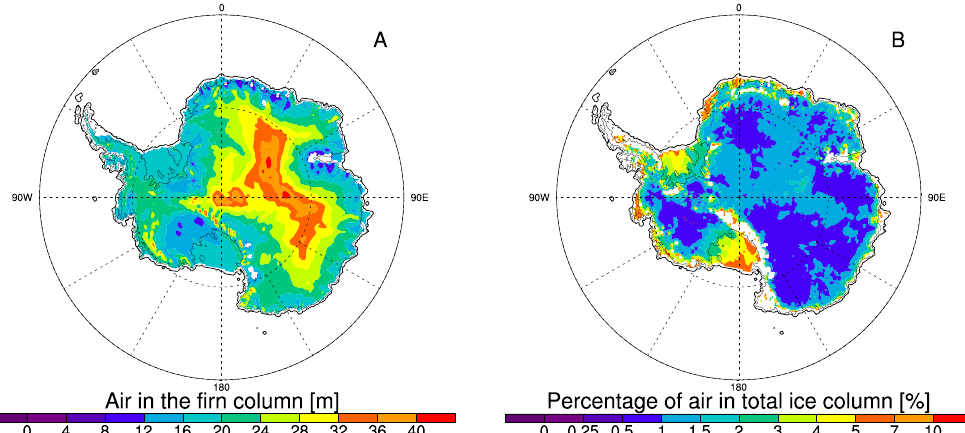
Fig. 8: The modelled amount of air in the firn column, expressed as the firn correction in m (A) and as a fraction of the total thickness of the ice in % (B) .